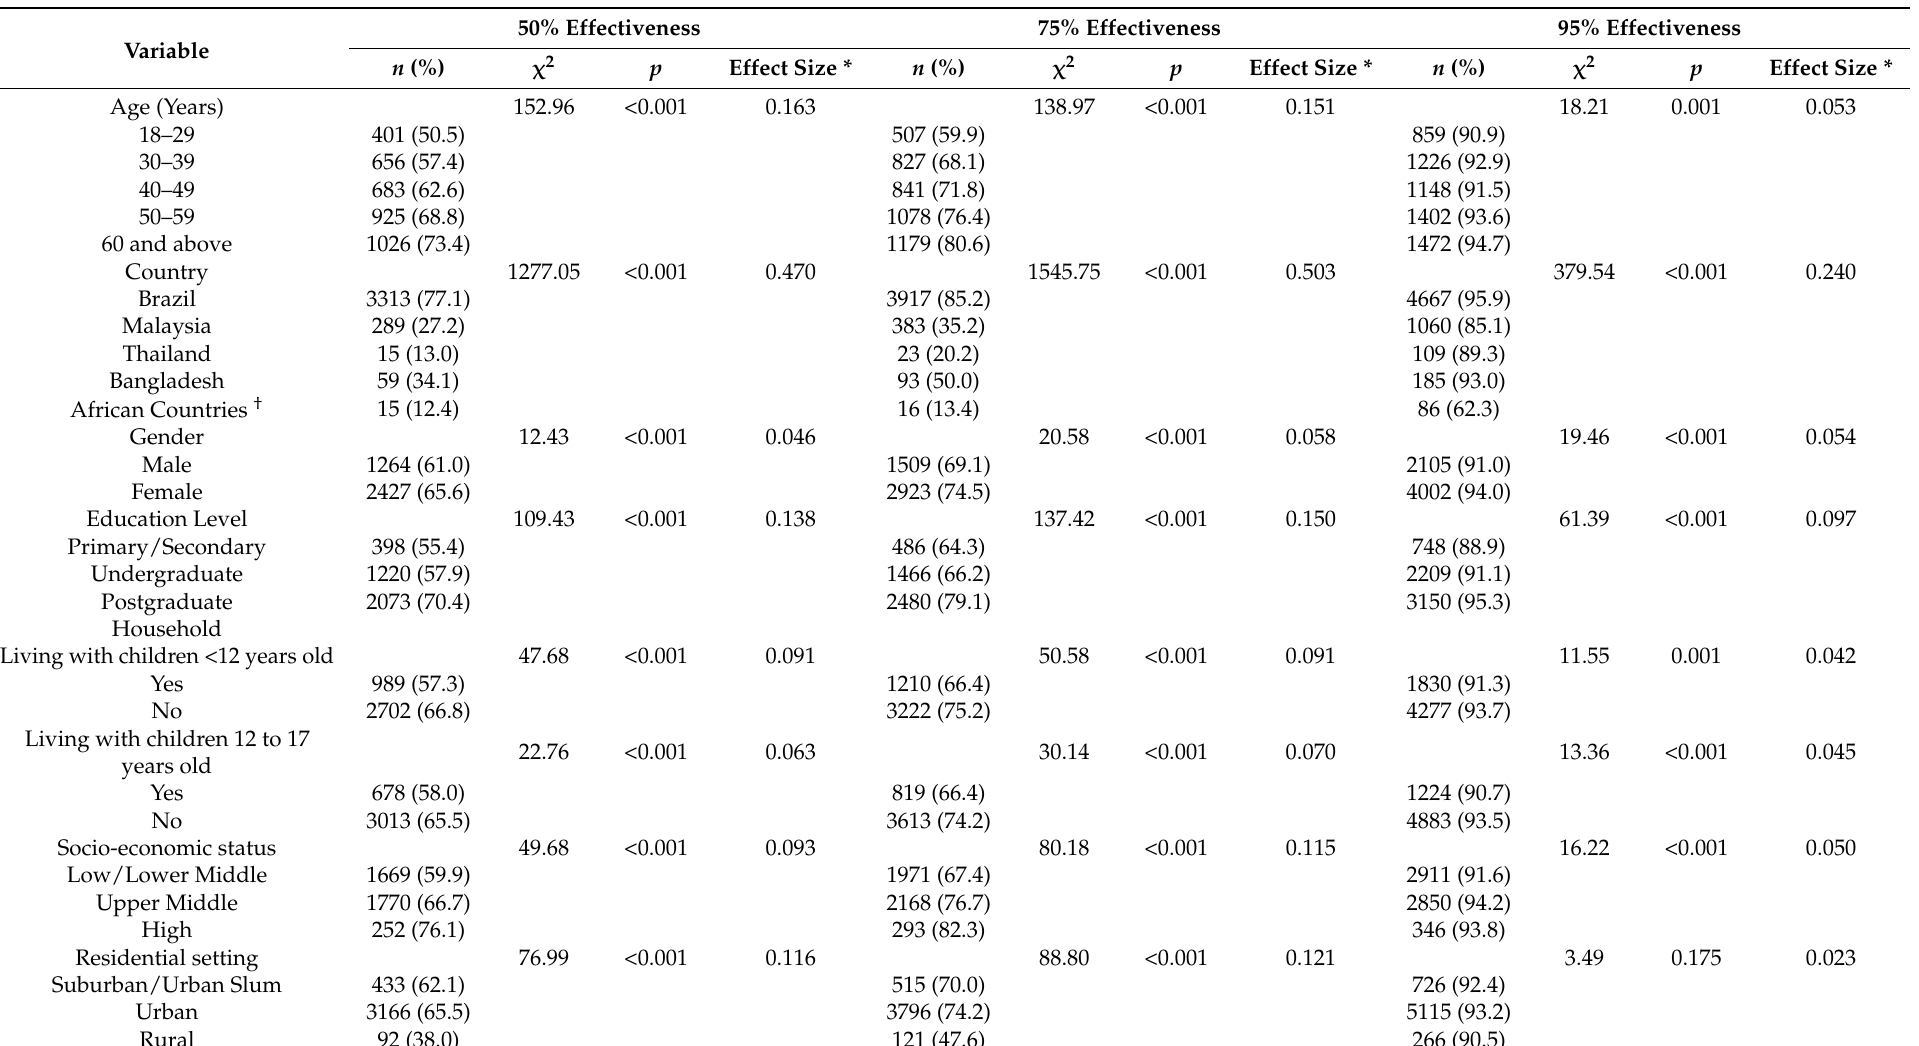
Table 3. Bivariate analysis of associations between demographic variables, knowledge, and attitudes towards COVID-19 vaccination and vaccine